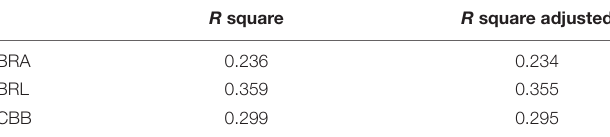
TABLE 5 | Strength of